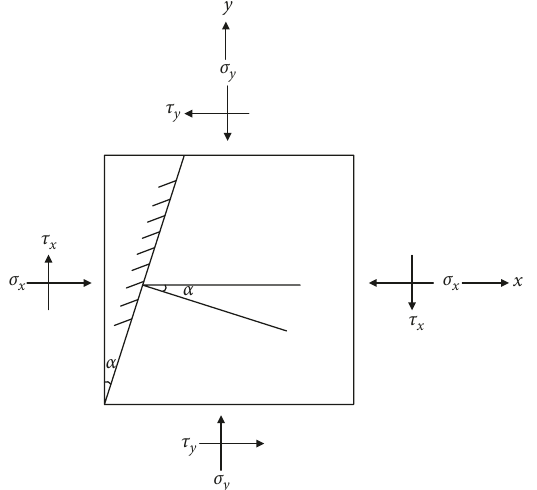
Figure 13: Microunit plane stress state in the failure plane of the mortise and tenon joint.